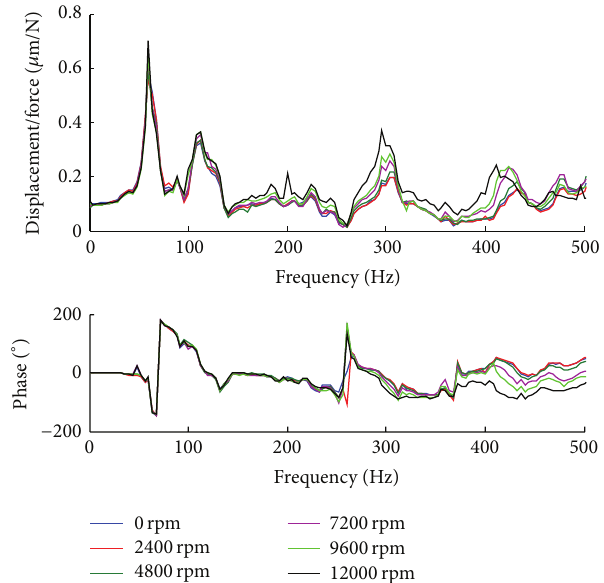
Figure 13: Frequency response curves of spindle displacement relative to machine working table at different speeds.